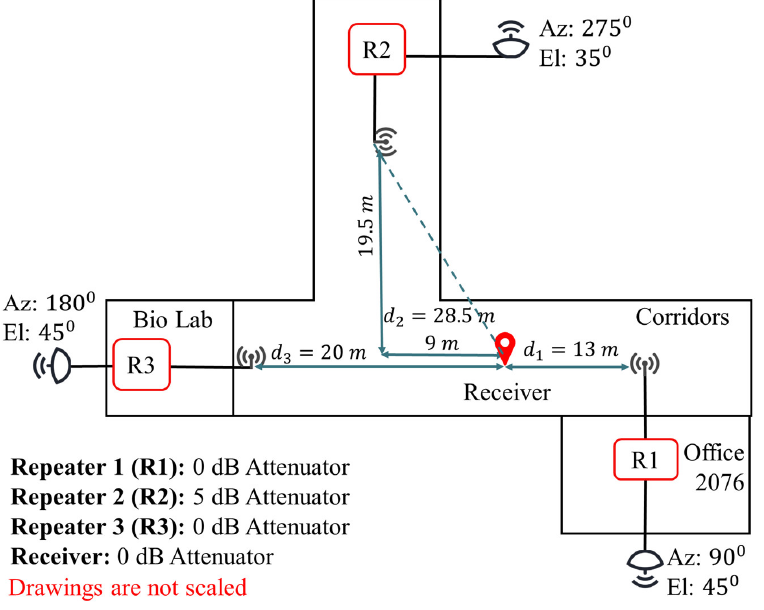
Figure 11. Distance between the receiver and each repeater, directional GPS antenna azimuth (Az) and elevation (El), and the attenuator value in each repeater in Experiment 2. and elevation (El), and the attenuator value in each repeater in Experiment